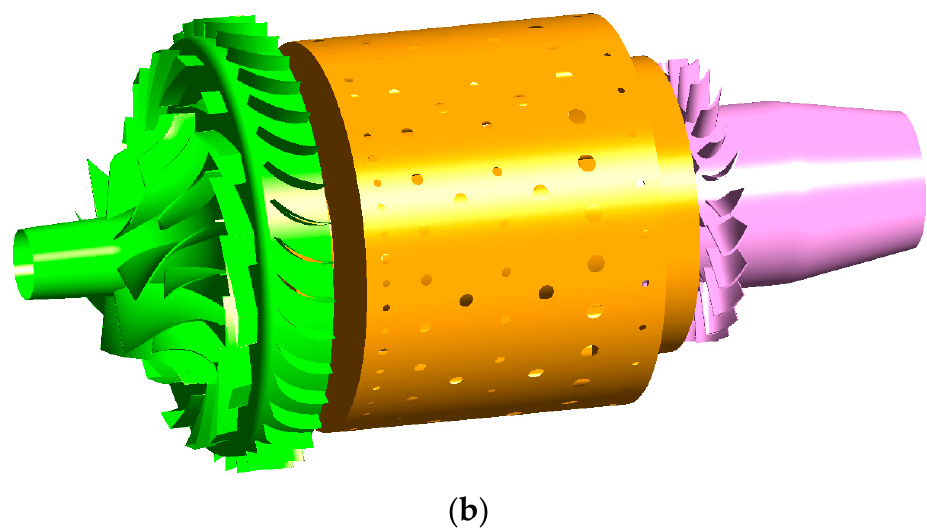
Figure 1. Three-dimensional CAD model of the micro-gas turbine: ( a ) cross-section view; ( b ) whole view.